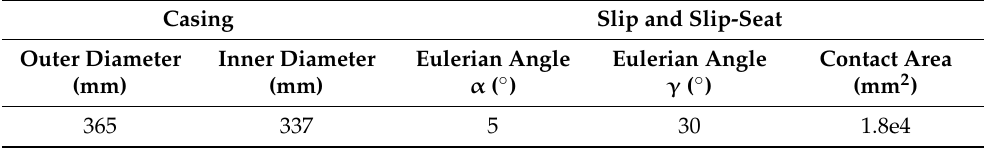
Table 1. Geometric parameter of hanging mechanism.